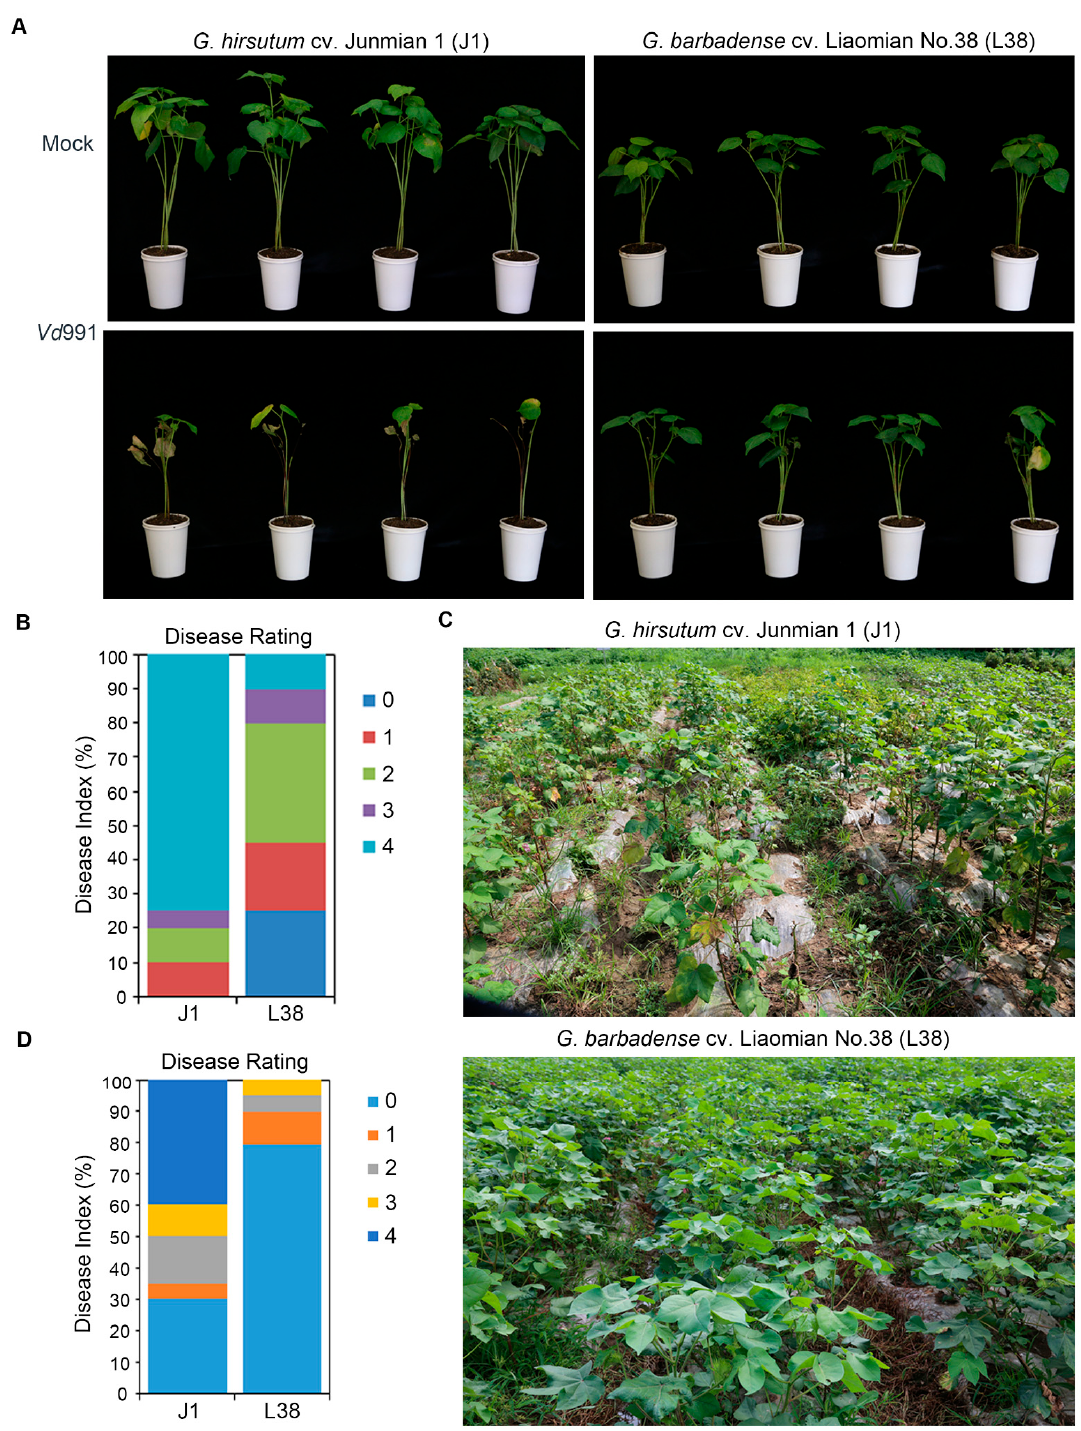
Figure 1. Phenotype of Gossypium hirsutum cv. Junmian No.1 (J1) and cv. Liaomian No. 38 (L38) cotton defense against Verticillium dahliae . ( A ) Disease symptoms of J1 and L38 cotton following inoculation with V. dahliae strain Vd991 and treatment with water as mock/control. The severity of cotton wilting as shown in the corresponding pictures recorded at 14 days post inoculation (dpi). ( B ) Disease index of J1 and L38 cotton were determined at 14 dpi after Vd991 inoculation. Disease grade 0, 1, 2, 3, and 4 showed the disease range from asymptomatic to lethal. ( C ) Disease symptoms of J1 and L38 cotton planted in disease nursery of Liaoyang city at July 2021. ( D ) Disease index of J1 and L38 cotton planted at the Liaoyang disease nursery was determined during July 2021. Disease grades 0, 1, 2, 3, and 4 encapsulate the disease from asymptomatic to